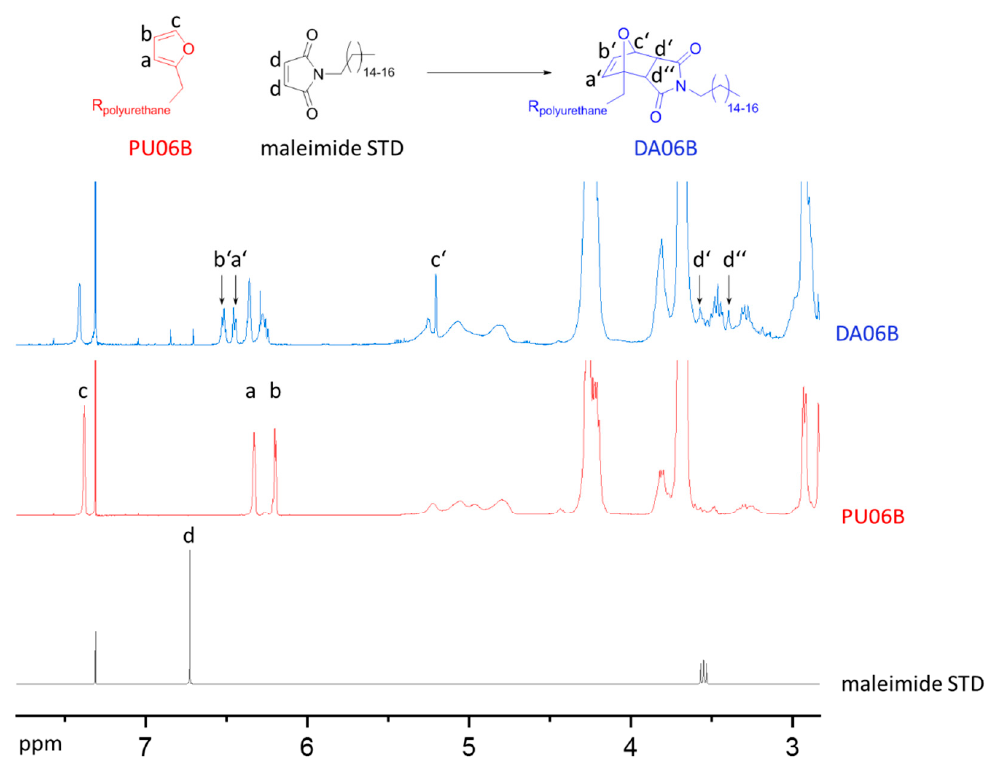
Figure 4. Section of changed 1 H-NMR signals through the Diels–Alder reaction of linear polyurethane with maleimide.